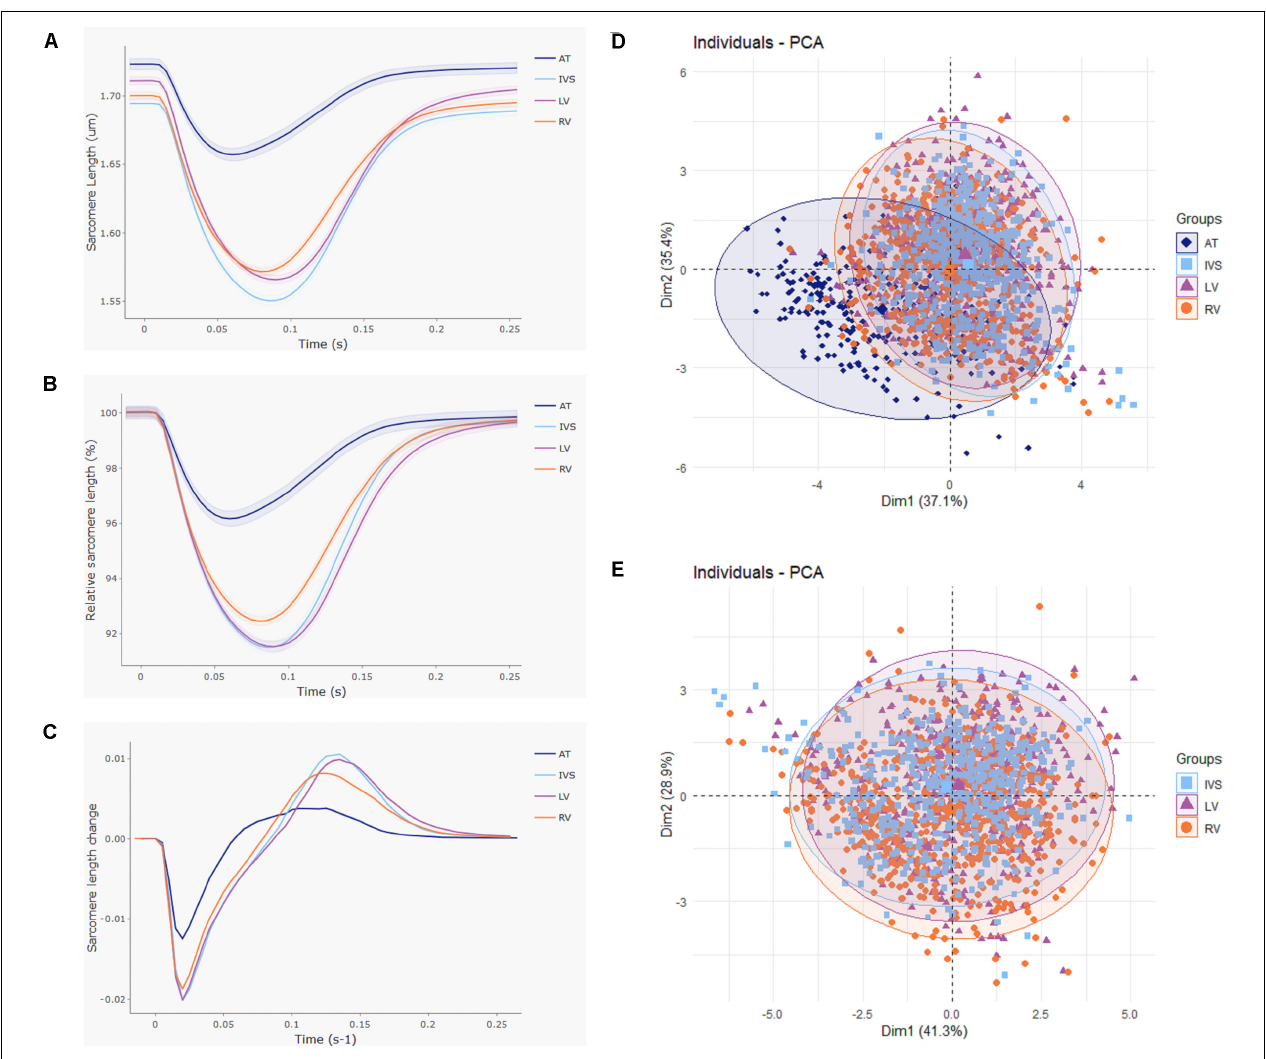
FIGURE 4 | Large atrioventricular and small interventricular differences in contractile function. Contractile function was compared between cardiomyocytes isolated from atria (AT; n = 272), left (LV; n = 553), and right ventricle (RV; n = 711) and interventricular septum (IVS; n = 507) from five rats. (A) Averaged and (B) normalized contraction traces and (C) averaged velocity traces for each cardiac region. Shading indicates SEM. (D) Principal component analysis displays clear clustering of AT cells. (E) Principal component analysis with AT cells omitted shows no separate clusters at the ventricular